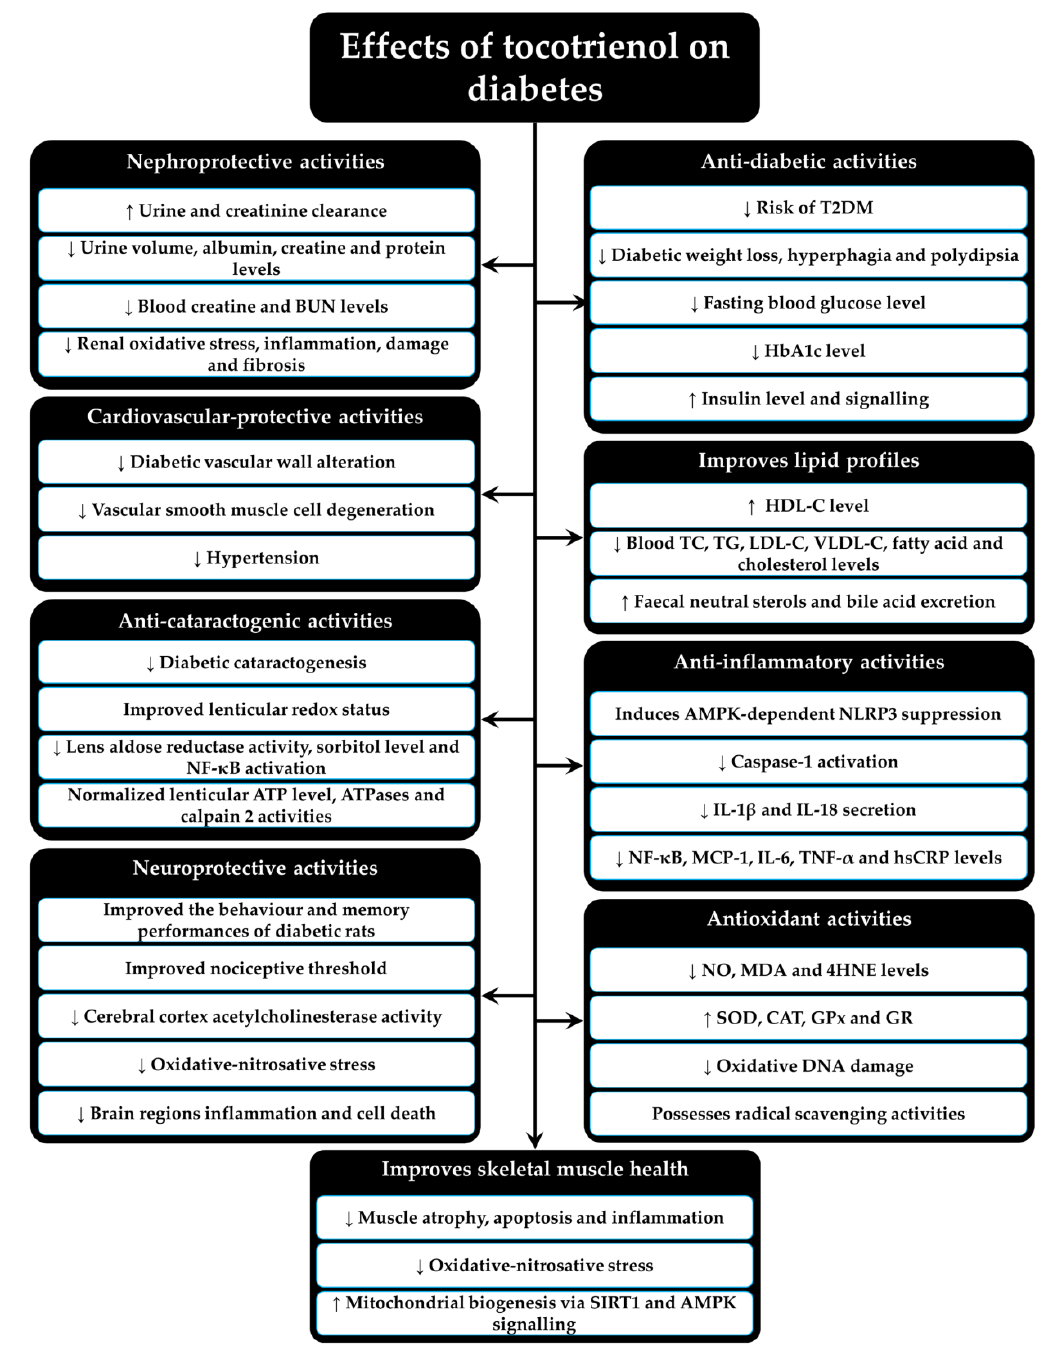
Figure 3. The beneficial effects of tocotrienol on diabetes from preclinical and clinical studies. Abbreviations: ↑ = increase or upregulate, ↓ = decrease or downregulate, AMPK = 5 ′ -adenosine monophosphate-activated protein kinase, BUN = blood urea nitrogen, CAT = catalase, GPx = glutathione peroxidase, GR = glutathione reductase, HbA1c = glycated hemoglobin, HDL-C = high-density lipoprotein, hsCRP= high sensitivity-C reactive protein, 4HNE = 4-hydroxynonenal, IL-1 β = interleukin 1 β , IL-6= interleukin 6, IL-18= interleukin 18, LDL-C = low-density lipoprotein, MCP-1= monocyte chemotactic protein-1, MDA= malondialdehyde, NF- κ B = nuclear factor- κ B, NLRP3= nucleotide-binding oligomerization domain-like receptor protein 3, NO = nitric oxide, SIRT1= sirtuin 1, SOD= superoxide dismutase, T2DM= type 2 diabetes mellitus, TC = total cholesterol, TG = triglyceride, TNF- α = tumor necrosis factor- α , VLDL-C = very low-density lipoprotein